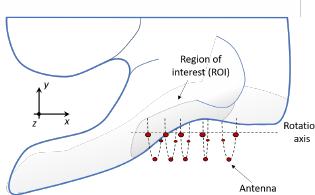
Figure 6. Illustration of the setup for axillary lymph node microwave imaging. The patient lays in a supine position, while the antennas scan the underarm